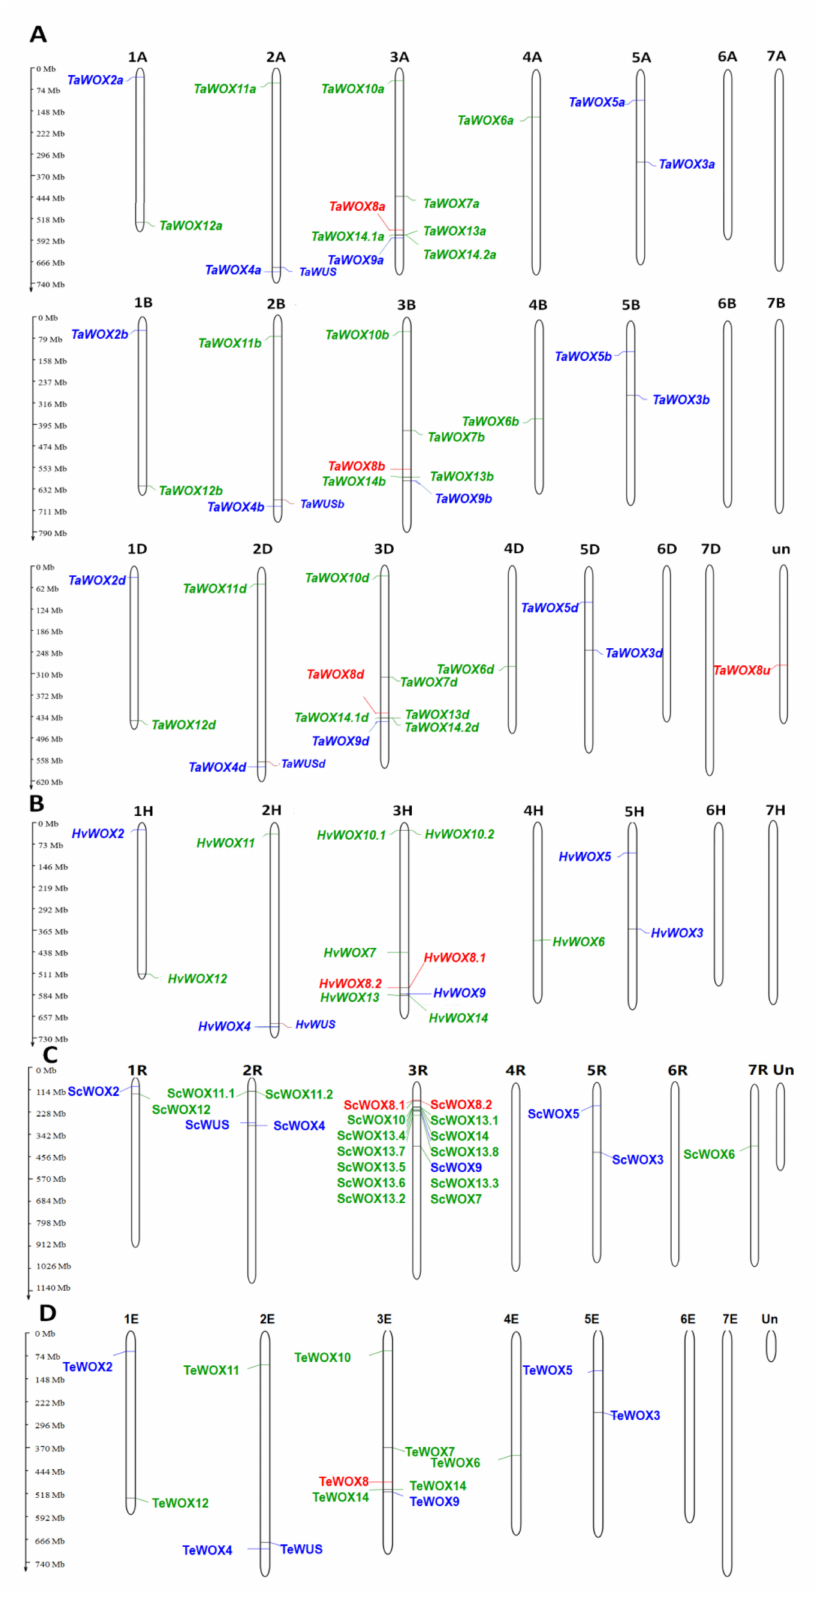
Figure 2. Chromosomal locations of WOX genes in T. aestivum ( A ), H. vulgare ( B ), S. cereale ( C ) and T. elongatum ( D ). The number of chromosomes was labeled on the top of each chromosome. The location of each WOX genes was marked on the chromosome. The WOX members in WUS clade, intermediate clade and ancient clade were shown as blue, green, and red types,